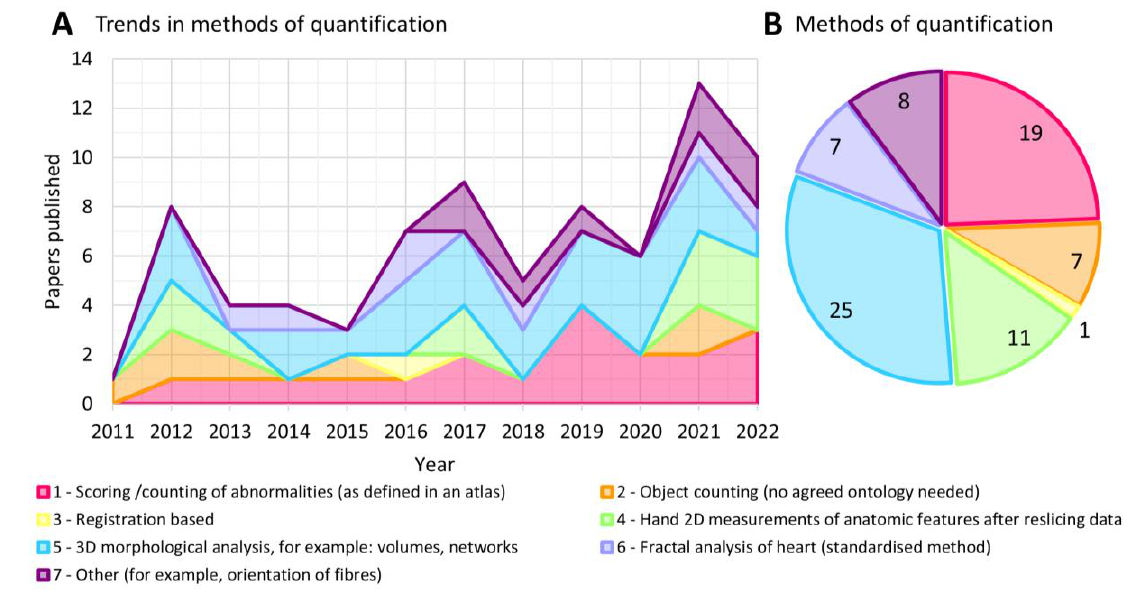
Figure 4. ( A ) This graph shows the trends in methods of image quantification over the last decade. The number of papers employing any method of quantification increased over time, with scoring of abnormalities (method 1) and 3D morphological analysis (method 5) showing the greatest increase. ( B ) The total number of papers using each quantification method since 2011 are shown in a pie chart, highlighting the scoring of abnormalities and 3D morphological analysis as the two most commonly used methods.